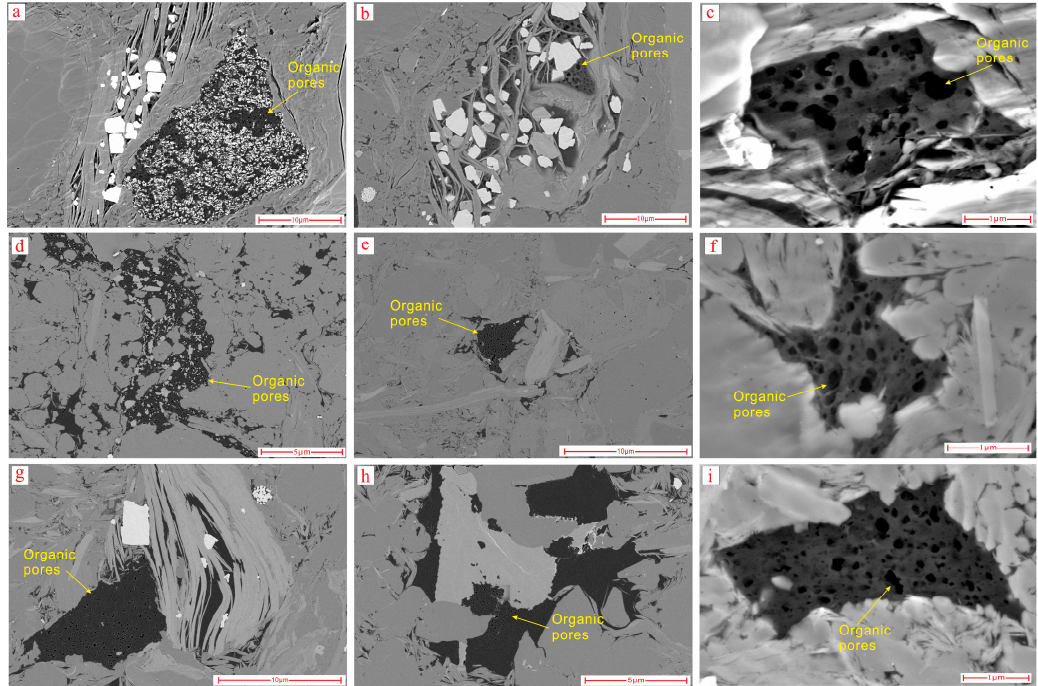
Figure 10. Comparison of the morphology of organic pores in the Mbr 1 1 of Longmaxi Fm shale reservoirs with different pressure coefficients. ( a – c ) Well L-2 with a pressure coefficient of 2.24; ( d – f ) Well H-2 with a pressure coefficient of 2.04; ( g – i ) Well Z-2 with a pressure coefficient of 1.86.